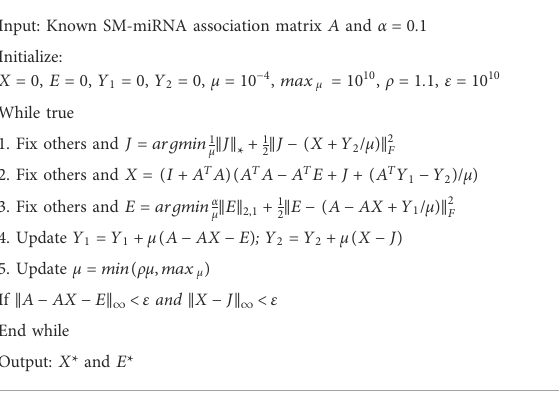
TABLE 1 The illustration of the IALM algorithm. Algorithm: Inexact augmented lagrange